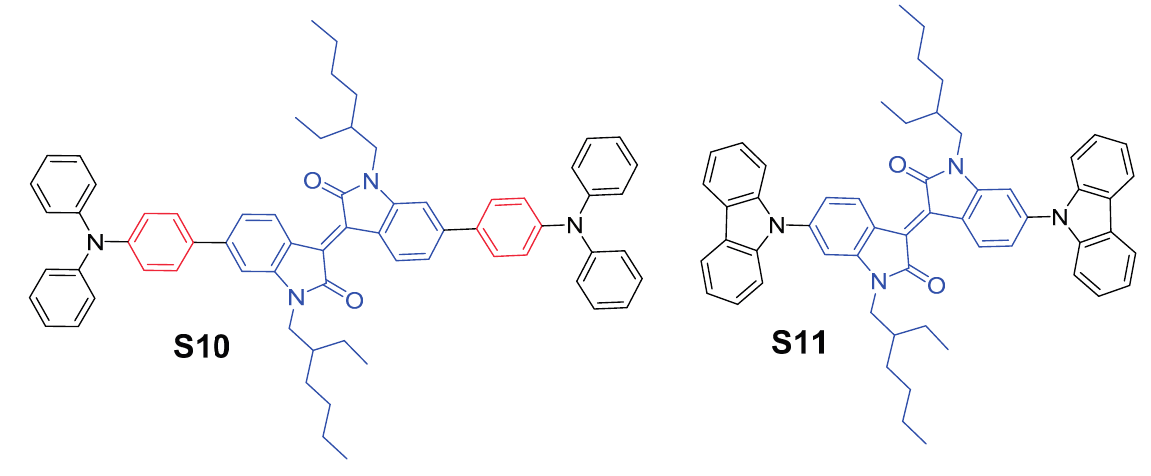
Figure 1. Molecular structures of the new organic materials investigated in this